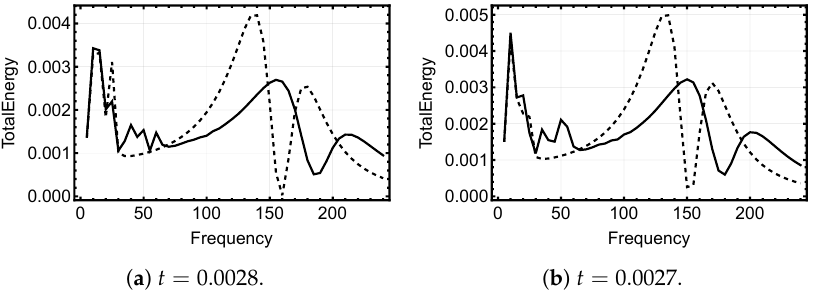
Figure 9. Fourier K = 20: Comparison of the full (solid line) and low-rank approximation (dashed line) over a range of frequencies. Low-rank approximation picks a higher